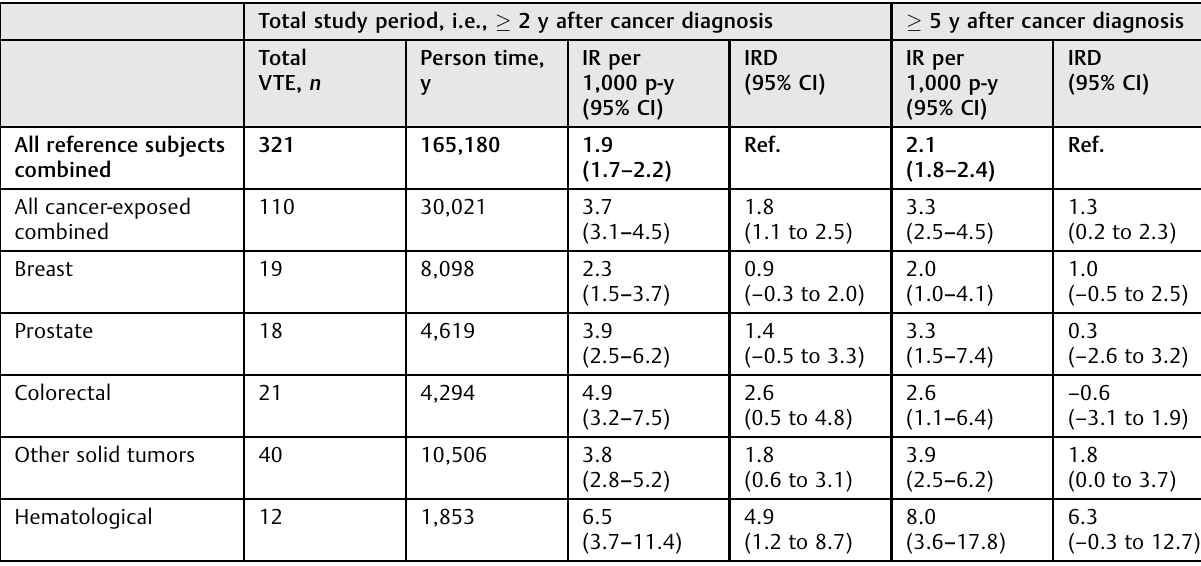
Table 2 IRs and IRDs of VTE in cancer-exposed subjects and their matched reference subjects by increasing time since cancer